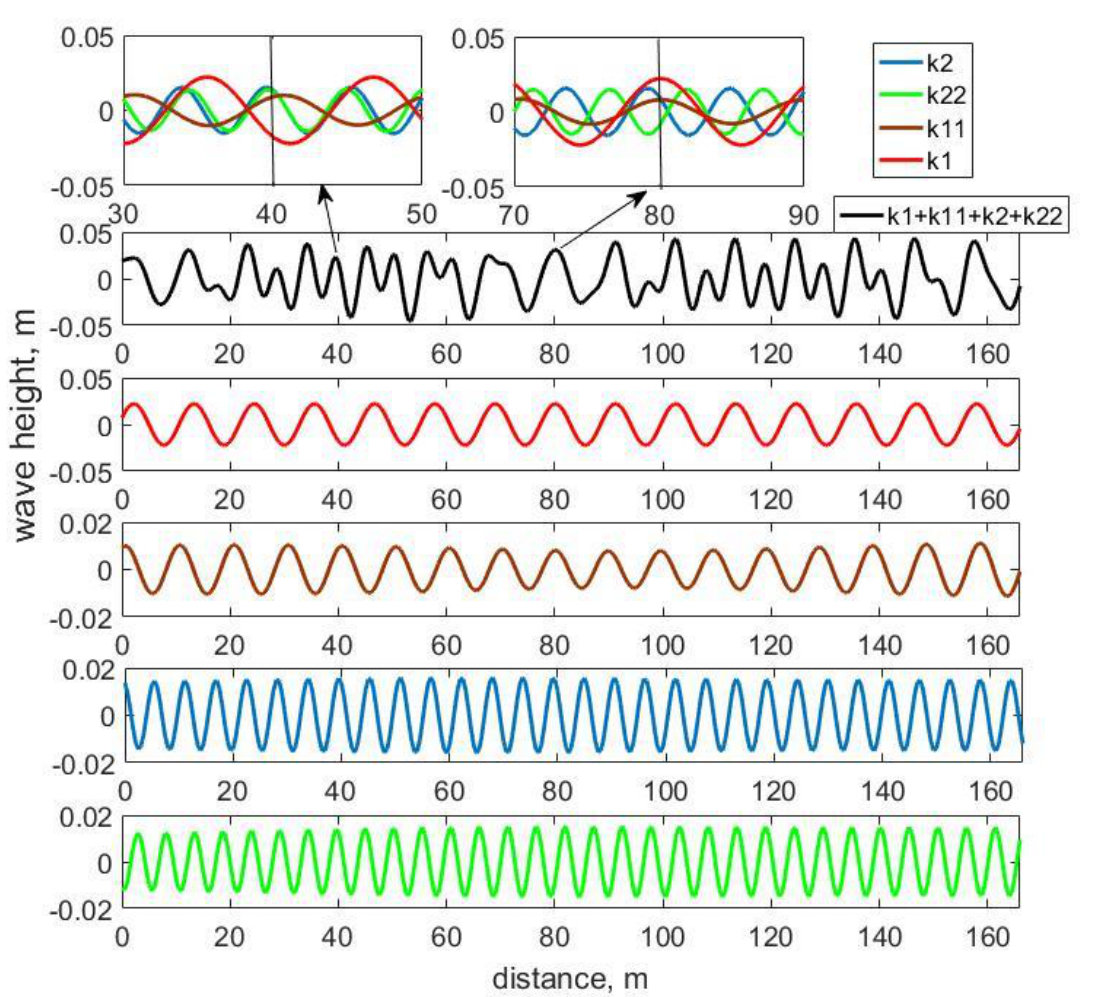
Figure 7. Demonstration of interference of waves corresponding free and bound waves of wave harmonics of model monochromatic wave propagated over constant depth 0.5 m.